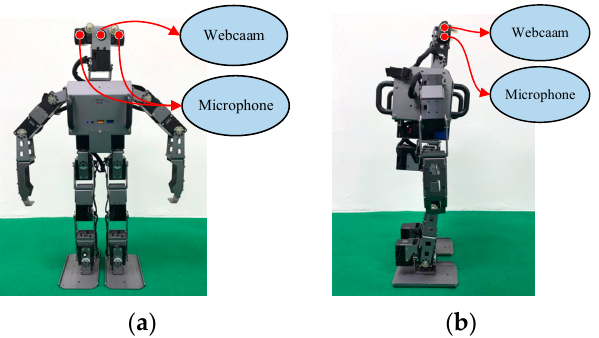
Figure 4. The architecture of the humanoid robot: ( a ) the front view; and ( b ) the side view.